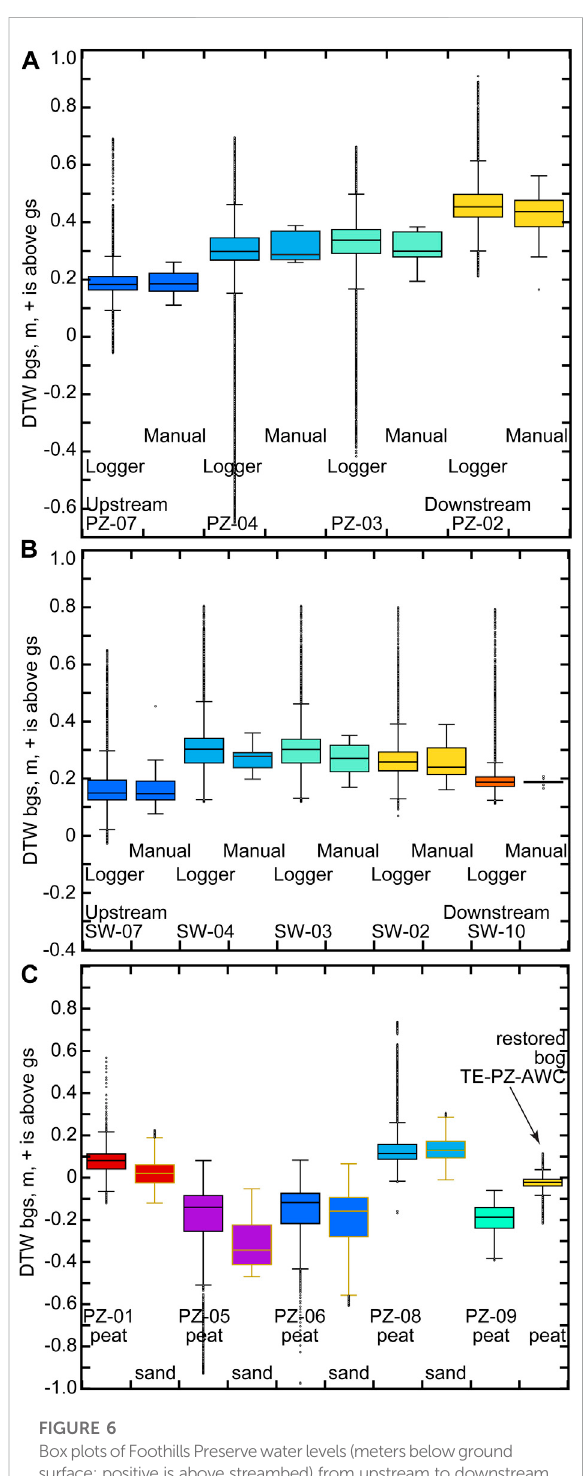
FIGURE 6 BoxplotsofFoothillsPreservewaterlevels(metersbelowground surface; positive is above streambed) from upstream to downstream, manual measurements and logger data; (A) in streambed piezometers:TW-PZ-07,TW-PZ-04,TW-PZ-03,TW-PZ-02, (B) from the stream surface TW-SW-07, TW-SW-04, TW-SW-03, TW- SW-02 and TW-SW-10, (C) and in bog surface peat and sand-aquifer piezometers:TW-PZ-01and-SAND,TW-PZ-05,and-SAND,TW-PZ- 06,and-SAND,TW-PZ-08and-SAND,TW-PZ-09,andTE-PZ-AWC.